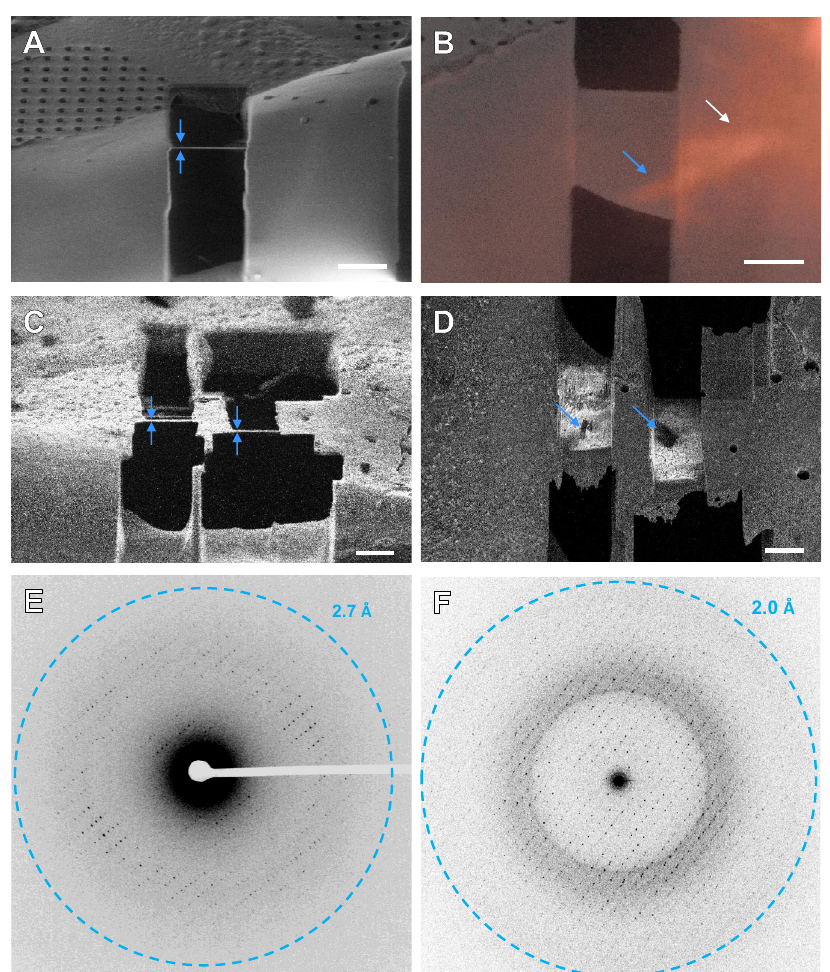
Fig. 6 | Milling A 2A AR microcrystals in thick LCP and MicroED data collection. A Finalmilledlamella of the GPCRcrystallabeled byCy3 in LCPviewedin the pFIB indicated by blue arrows. The fi nal thickness is ~250nm. B Overlaid SEM and iFLM 525nm fl uorescent images of the fi nal lamella con fi rming the crystal survived the milling process. The blue arrow depicts a milled portion of the crystal, and the white arrow shows an unmilled area of the crystal identi fi ed by the fuzzier